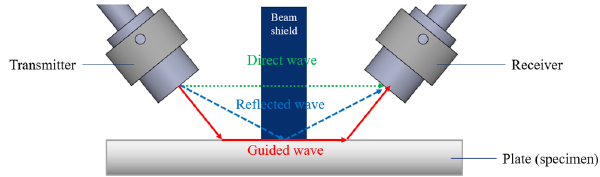
Figure 2. Schematic drawing of a beam shield in re-emission (single-sided) setup. In green, blue and red the different paths of possible wave propagation are shown.